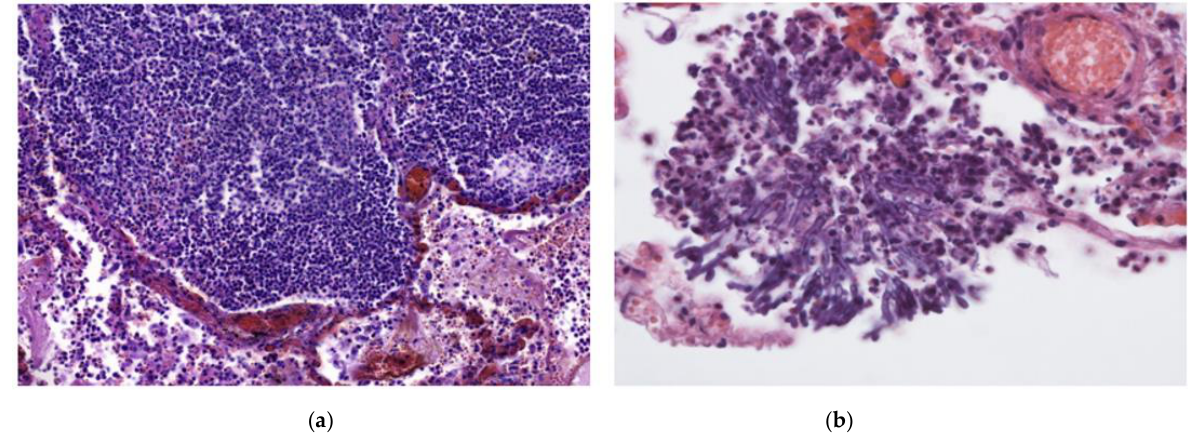
Figure 3. ( a ) In addition to DAD, this patient had an intense, focal inflammatory infiltrate primarily consisting of lymphocytes and foamy macrophages. H & E stain; magnification ×200. ( b ) Fungal hyphae found in the same patient as 3( a ). Fungal co-infection explains the dense inflammatory in- filtrate. H & E stain; magnification ×400.